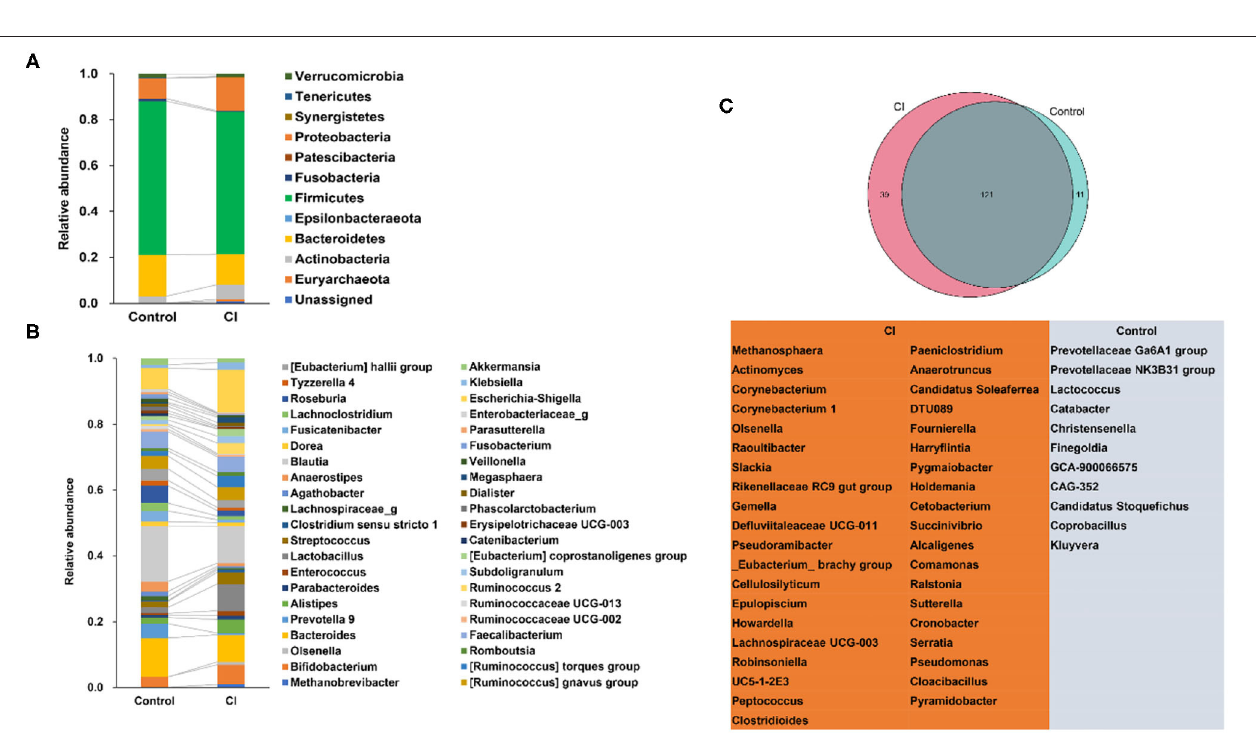
FIGURE 3 | Alterations of gut microbial composition. (A) Changes in gut microbes at the phylum level. (B) Changes in gut microbes at the genus level. (C) The special genera in the control and cognitive impairment (CI) groups.